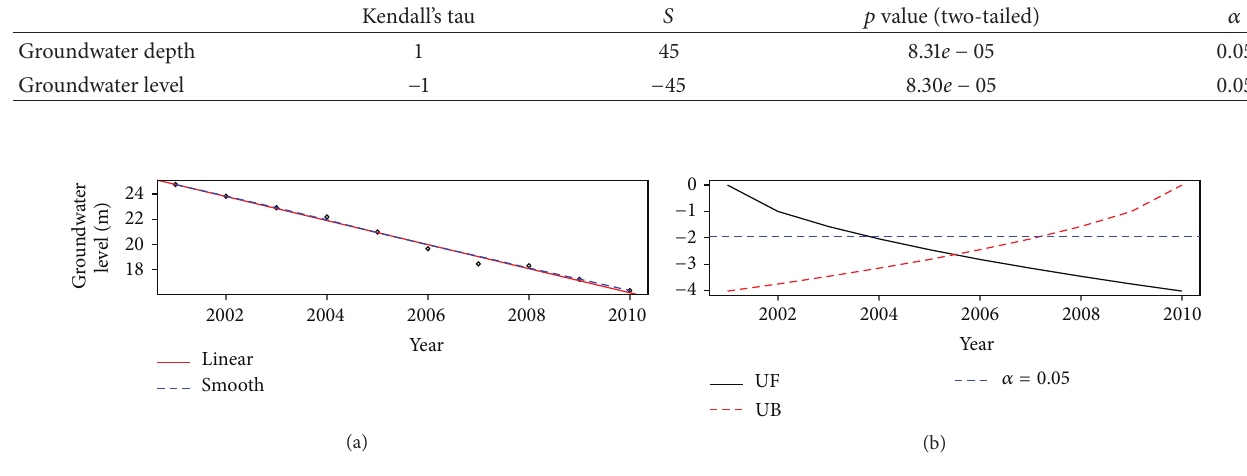
Figure 3: (a) Groundwater level variation during the period 2001 to 2010. (b) Mann-Kendall test results for groundwater level.